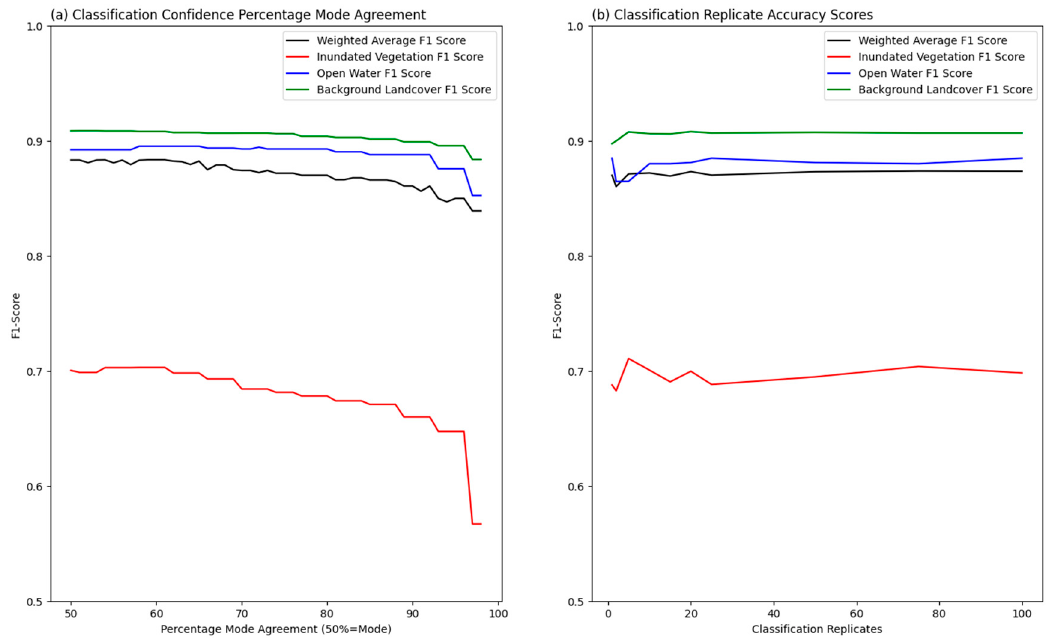
Figure 13. Classi fi cation sensitivity analysis. ( a ) Classi fi cation accuracy for each class and the weighted average F1 score for the classi fi cation as classi fi cation replicate mode agreement increases, ( b ) classi fi cation accuracy for each class and the weighted average F1 score for the classi fi cation as the number of replicates increases.